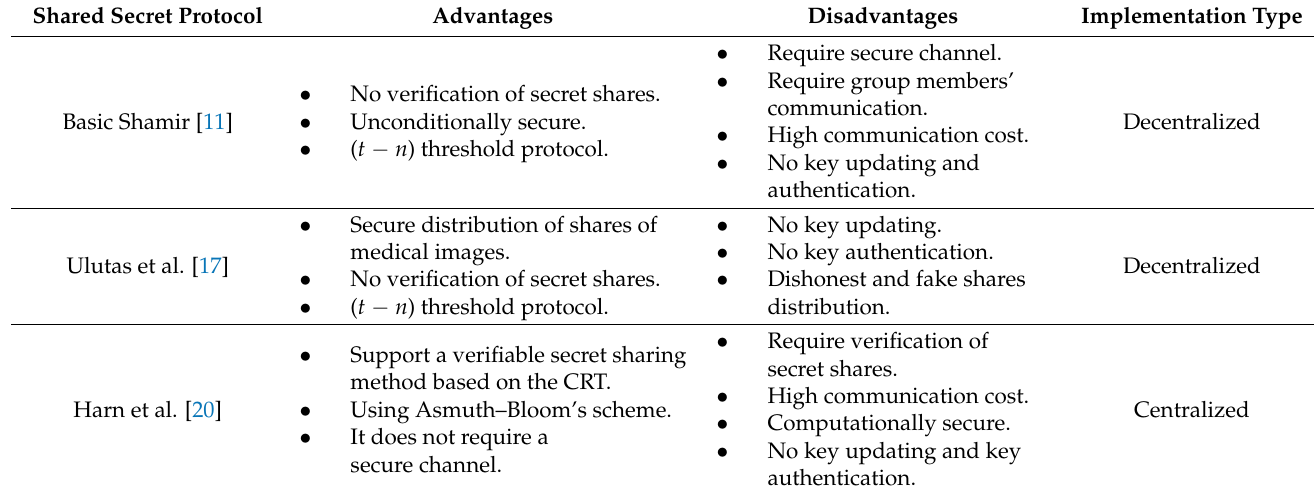
Table 2. Comparison of the previous shared secret protocols in terms of advantages and